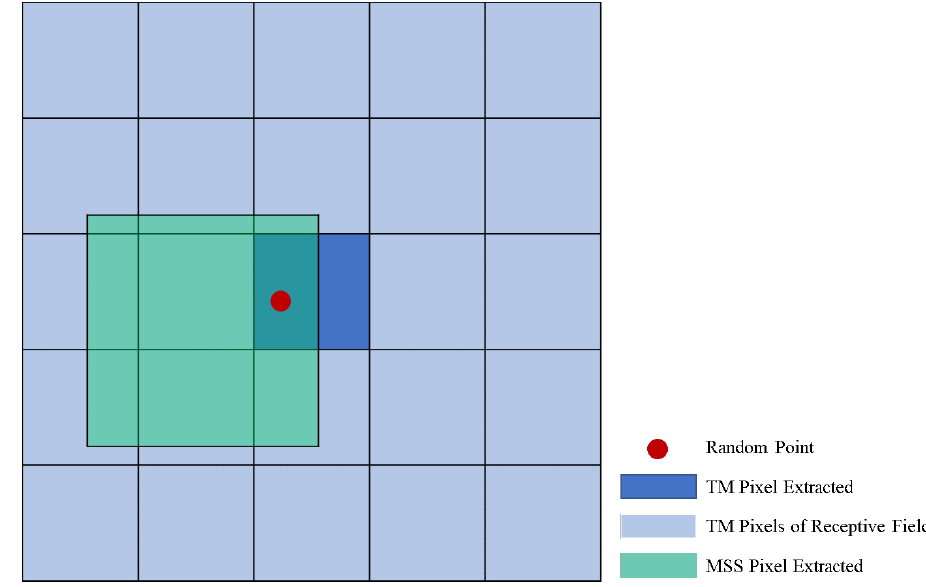
Figure 6. An example of MSS and TM pixels extract by random